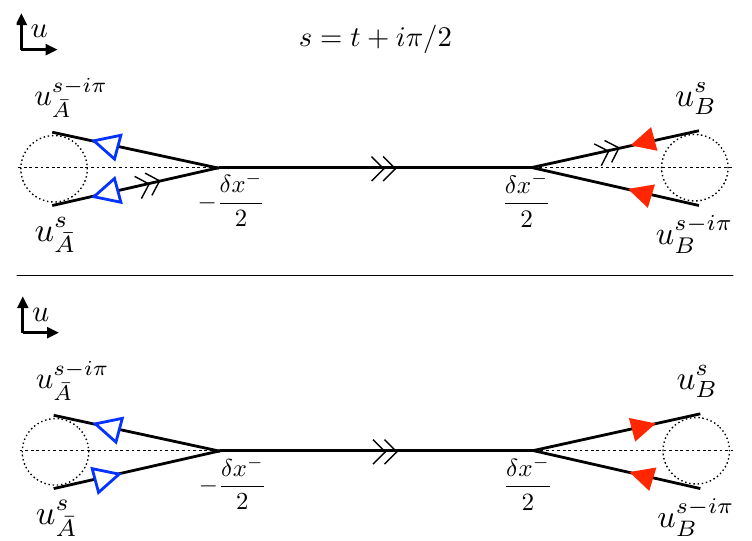
Figure 12 . Top : the piecewise integral contributions to ~ F J ( t + i(cid:25)= 2). The black double arrows are the contribution from the double (cid:13)ow correlator f ( s ), the blue open arrows are the contribution from the single (cid:13)ow correlator h (cid:22) ( s ), and the red solid arrows are the contribution from the single A (cid:13)ow correlator h B ( s ). The arrows point in the direction of integration. The dashed circles have radius (cid:14)x (cid:0) e (cid:0) s , which is the size of the s -dependent shift we have introduced in the coordinates 2 u . Bottom : the net integral contributions to ~ F J ( t + i(cid:25)= B; (cid:22) A